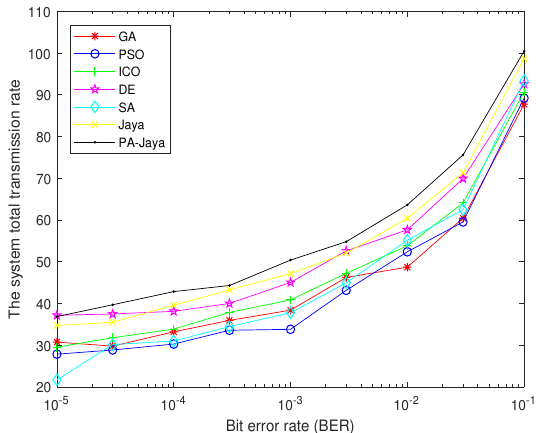
Figure 5. Relationship between the bit error rate (BER) and the total system transmission rate.